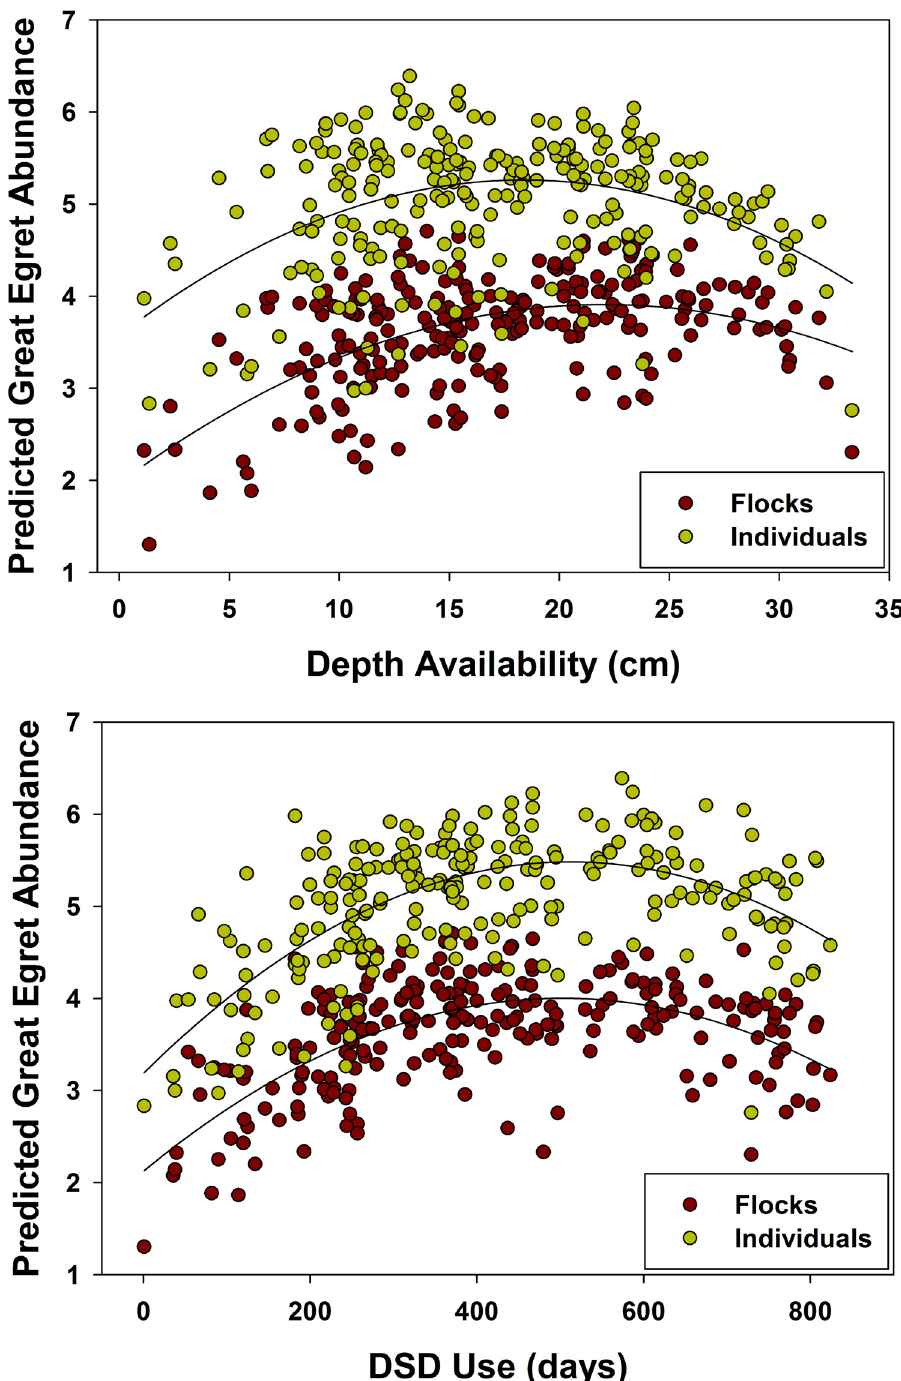
Fig 2. Daily mean landscape flocks and individuals (fourth-root transformed) predicted by the model- averaged terms for the Great Egret. Predicted presence and abundance are highest with an average landscape depth (within available depths) of 15 – 22 cm and when Great Egrets are using an average DSD of ~500 days.